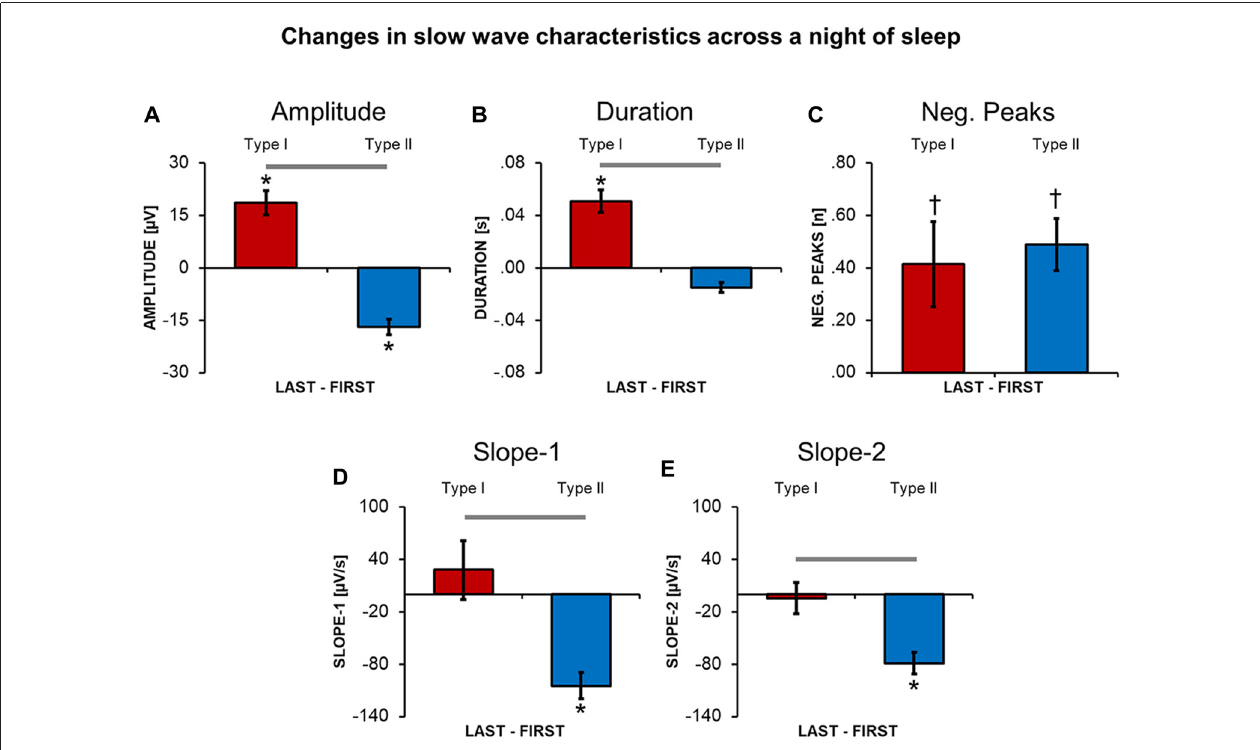
FIGURE 4 | Changes in slow wave characteristics throughout a night of continuous sleep. Each barplot displays the difference between the last and the first NREM sleep cycle for slow waves classified as type I or type II, in: amplitude (A) , duration (B) , number of negative peaks (C) , slope-1 (D) , slope-2 (E) . Vertical bars indicate standard errors (SE). Horizontal gray bars mark significant differences in relative overnight changes between type I and type II waves. Asterisks mark significant overnight changes for each slow wave type separately. ∗ Bonferroni corrected p < 0.05; † uncorrected p < 0.05.